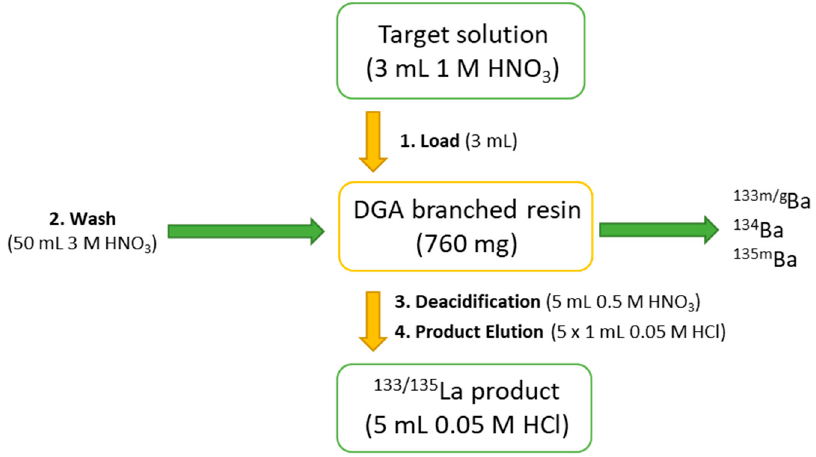
Figure 4. 133 La purification scheme.